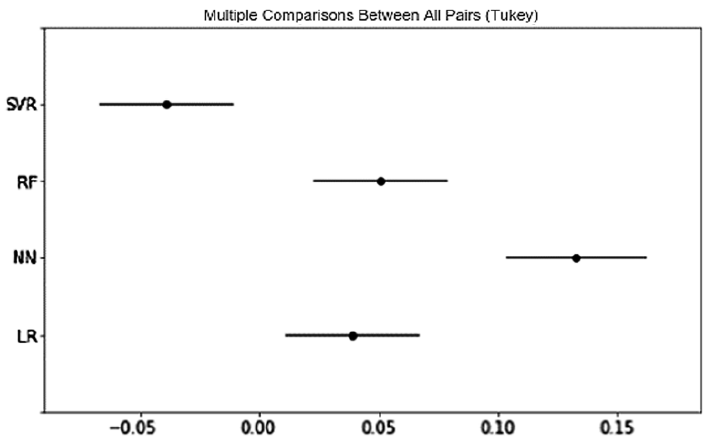
Figure 10. Multiple comparisons between all pairs (Tukey) in regression methods for psychographic segmentation-based rating prediction (RMSE).